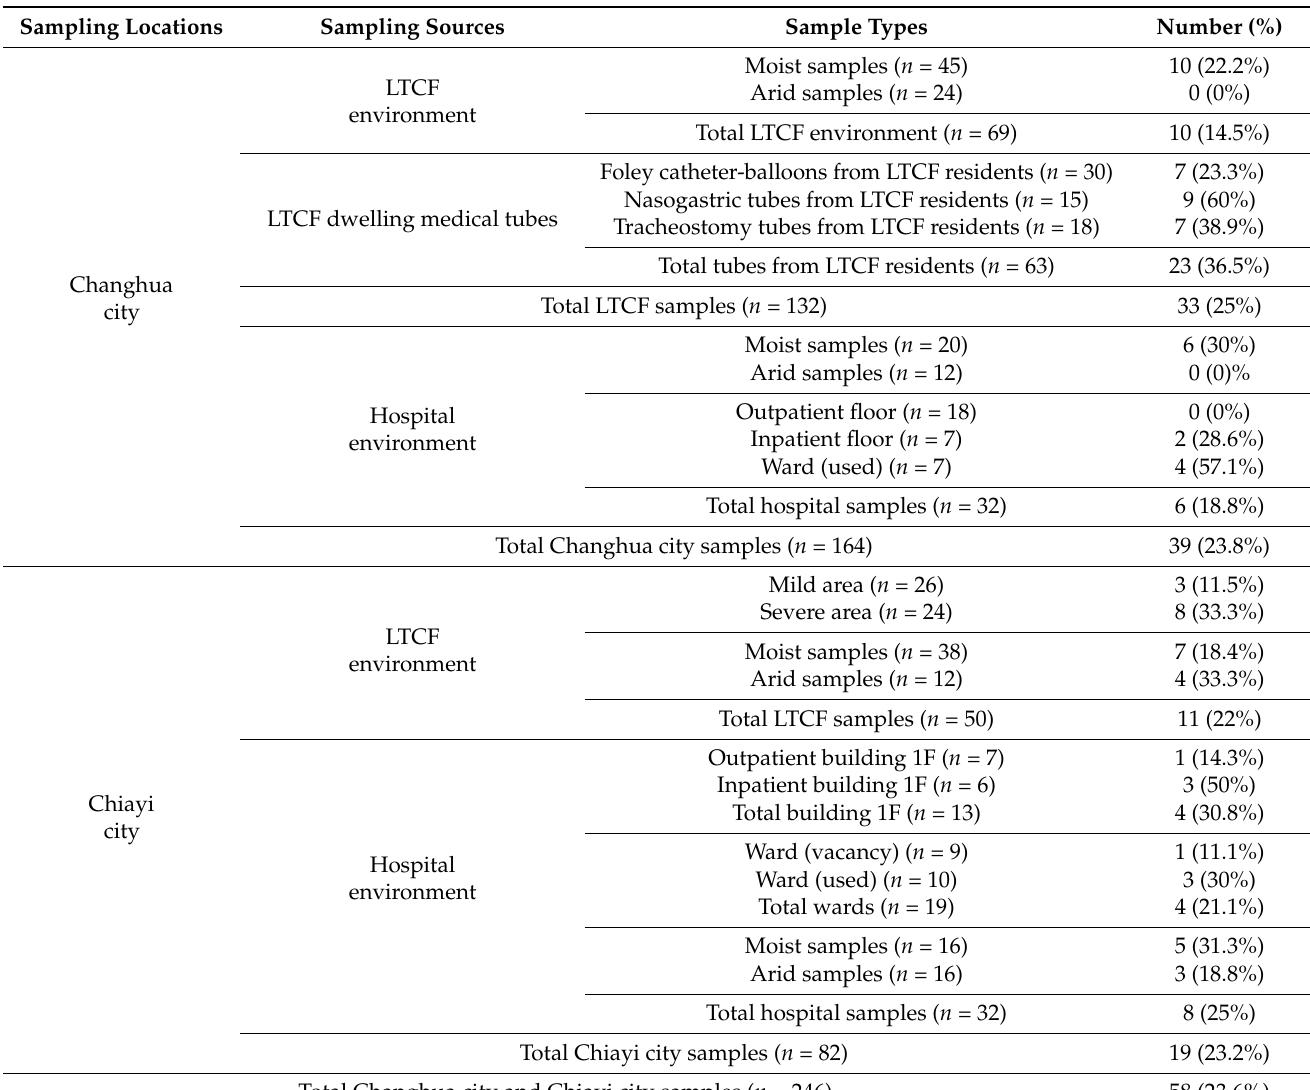
Table 1. Prevalence of MRSA from various